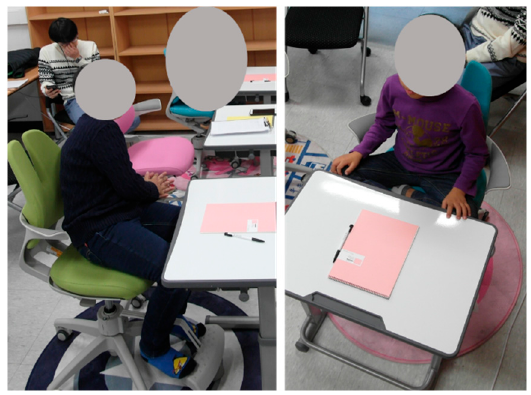
Figure 7. Experiment environment and the situation of data acquisition. Left: lean left; right: sitting crossed-legged on the chair.